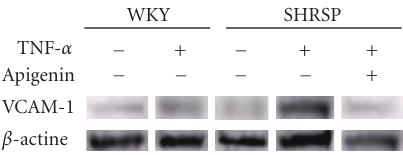
Figure 2: E ff ects of TNF- α and apigenin on VCAM-1 pro- tein expression levels in astrocytes isolated from WKY/IZM and SHRSP/IZM. The astrocytes isolated from WKY/IZM and SHRSP/IZM were incubated with TNF- α (10ng/mL) for 24 hours. Levels of VCAM-1 protein were determined by Western blot